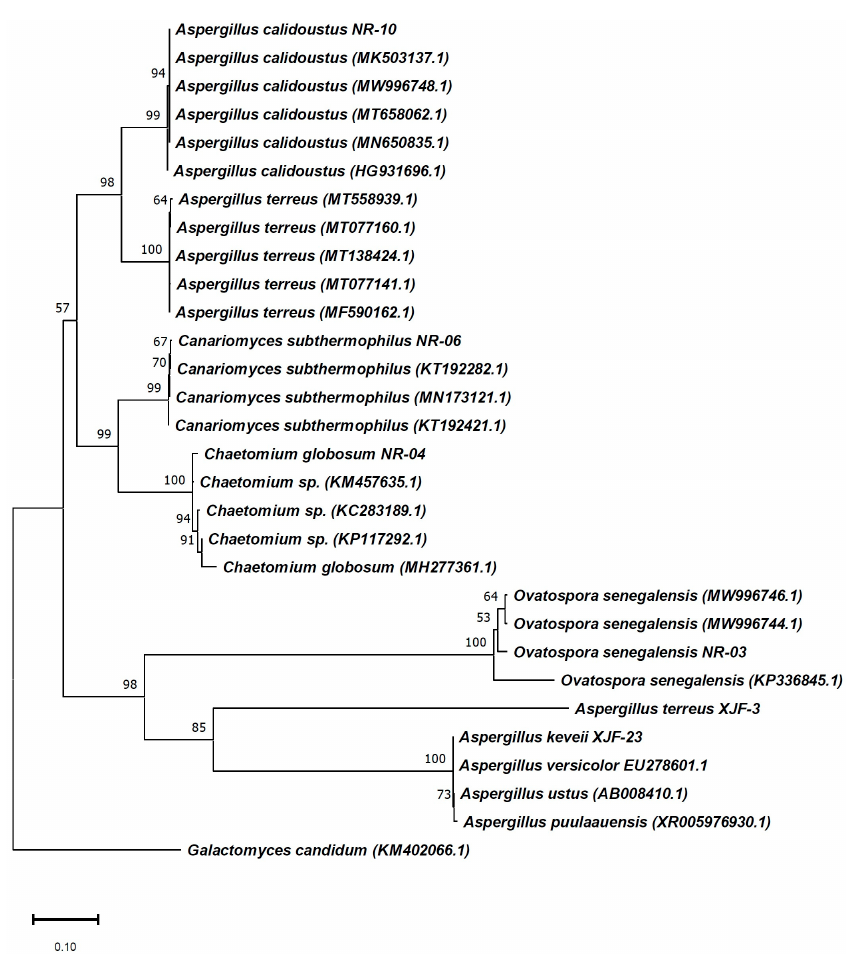
Figure 2. The phylogenetic tree of endophytic fungi isolated from V. anthelmintica , with the closest relatives registered in GenBank of NCBI. Table 2. Antimicrobial activity (ZOI) of endophytic fungi associated with medicinal plant V. anthel- mintica flowers.